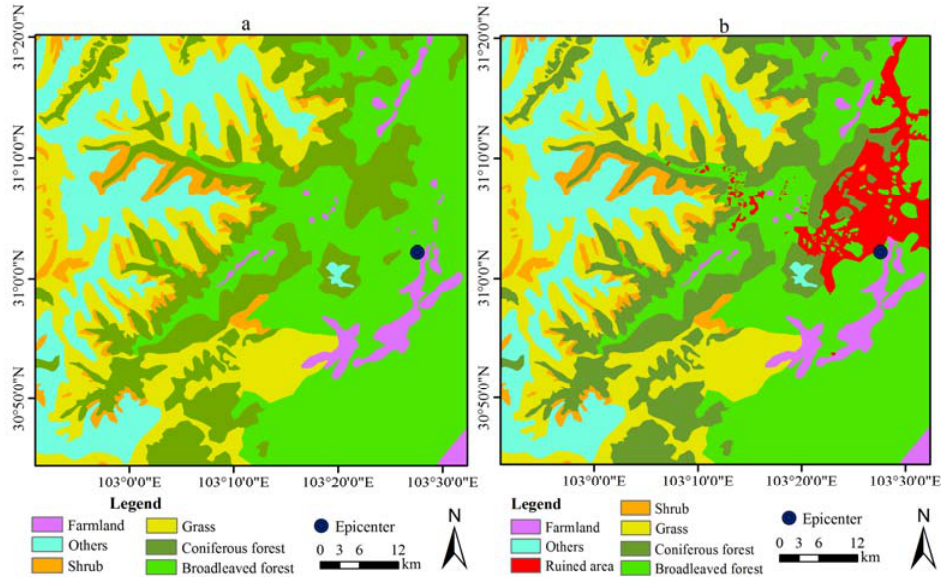
Figure 2. Vegetation type maps interpreted from two images of Landsat enhanced thematic mapper (ETM+) data before (5 April 2008) and after (23 May 2008) the Wenchuan earthquake. Vegetation type map ( a ) before the earthquake and ( b ) after the earthquake.